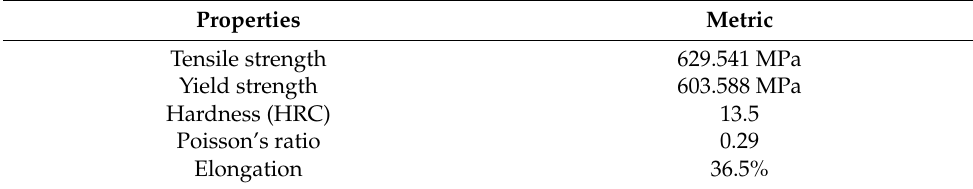
Table 8. Mechanical properties of AISI 1020 steel.